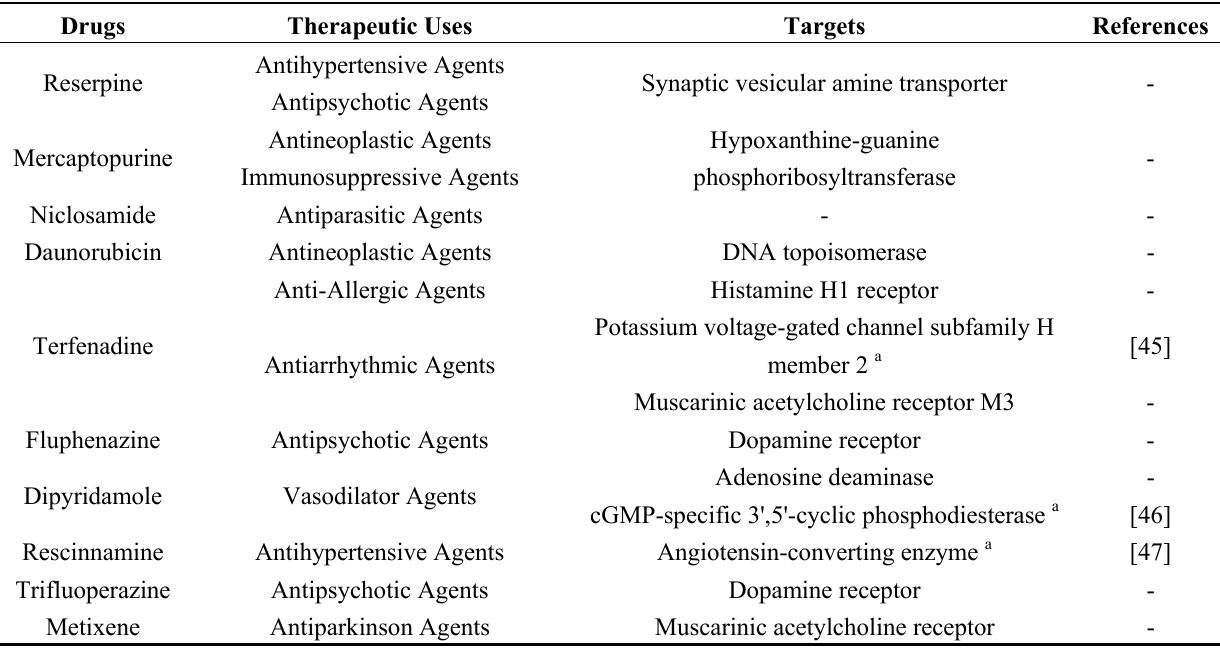
Table 3. Predicted similar drugs and associated targets of